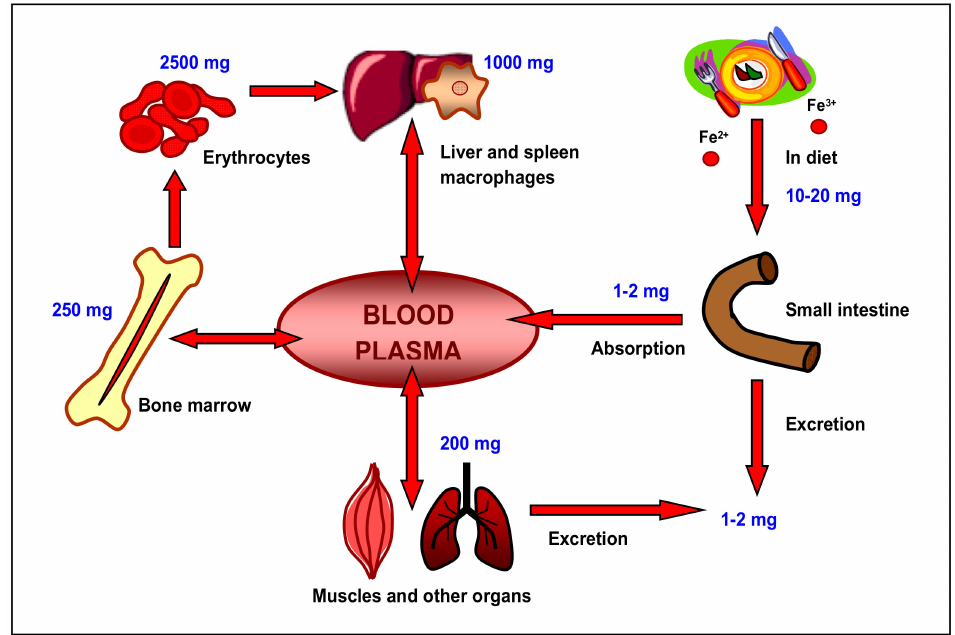
Figure 1. Turnover of iron in the human body. Given values indicate amounts of absorbed, used, stored and expelled